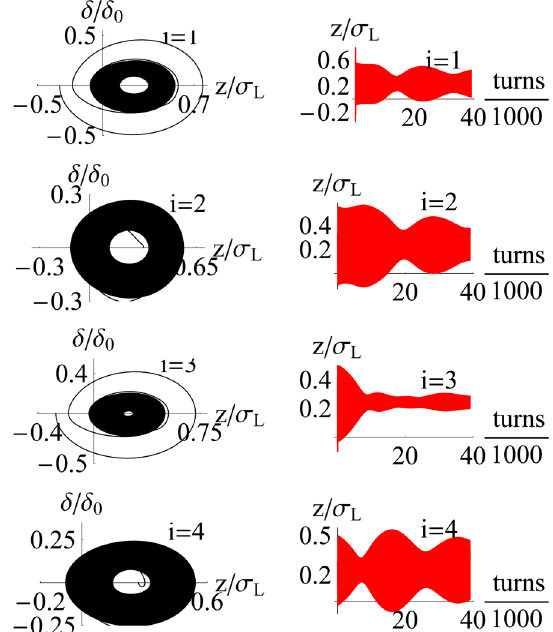
FIG. 8. (Color) Tracking of four particles with the feedback on. The i th row shows the trajectory in the phase plane (on the left) (cid:5) (cid:9) (cid:6) (on the right) for the i (cid:1) 1 ; 2 ; 3 ; 4 and the displacement (cid:7) i particle. The trajectory after one or two turns finds the fix point and then remains stable for 700 synchrotron periods.